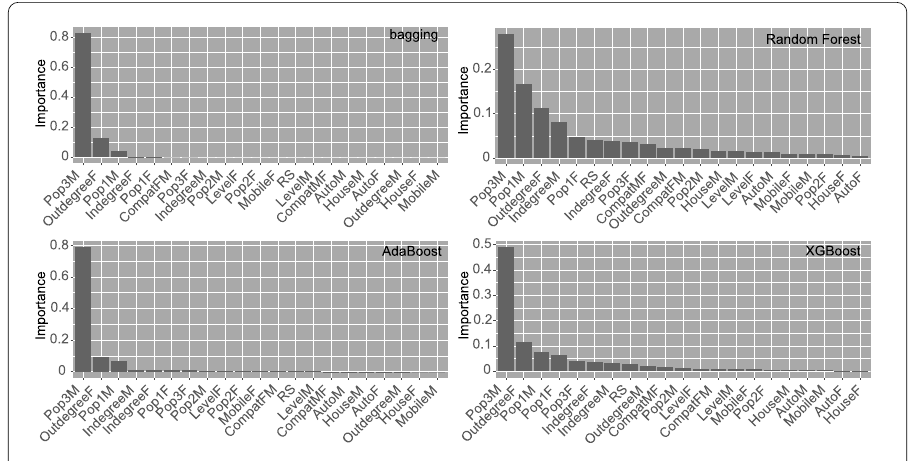
Figure 9 Attribute relative importance rankings when women send messages to men for different classification methods. The horizontal axis indicates the attributes and the vertical axis indicates their corresponding importance. For bagging, Random Forest, and AdaBoost, the relative importance of each variable in the classification task is measured by the Gini index, and for XGBoost the relative importance is measured by the Gain parameter